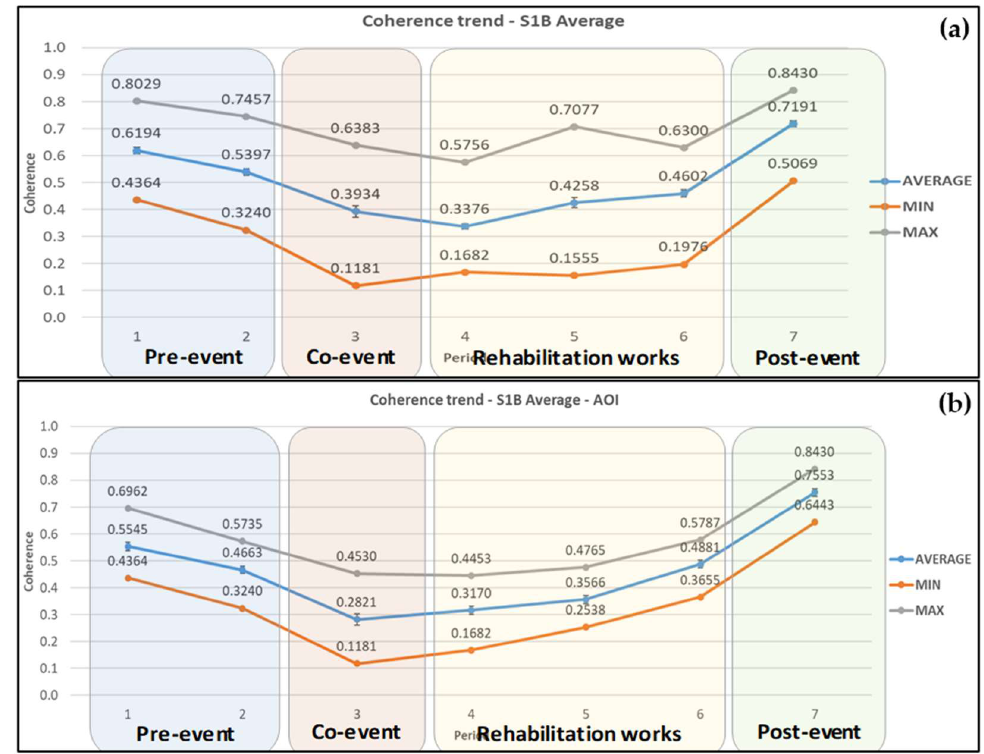
Figure 9. Average coherence changes obtained from Sentinel-1B ascending and descending satellite images for ( a ) the wider area and ( b ) the AOI. Error bars can be seen in the average coherence values.